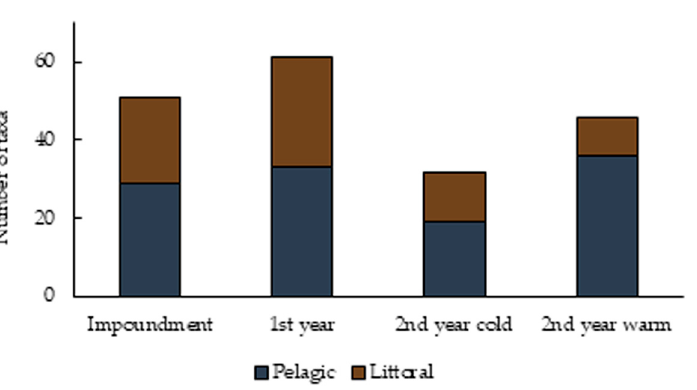
Figure 4. Number of pelagic and littoral taxa during the different phases of the Moglicë Reservoir.